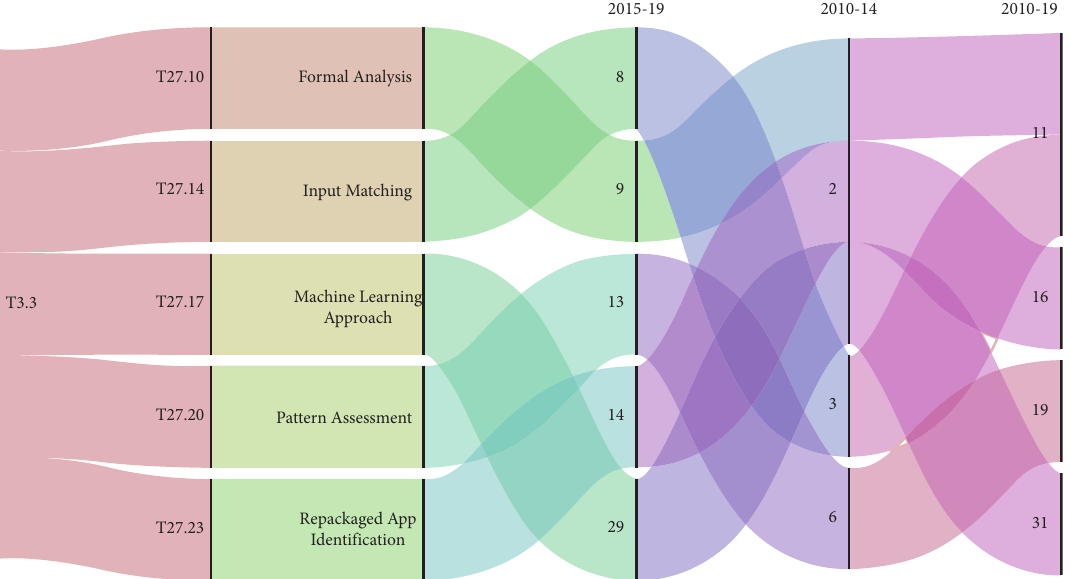
Figure 11: Mapping of core research area 3.3 and trends.